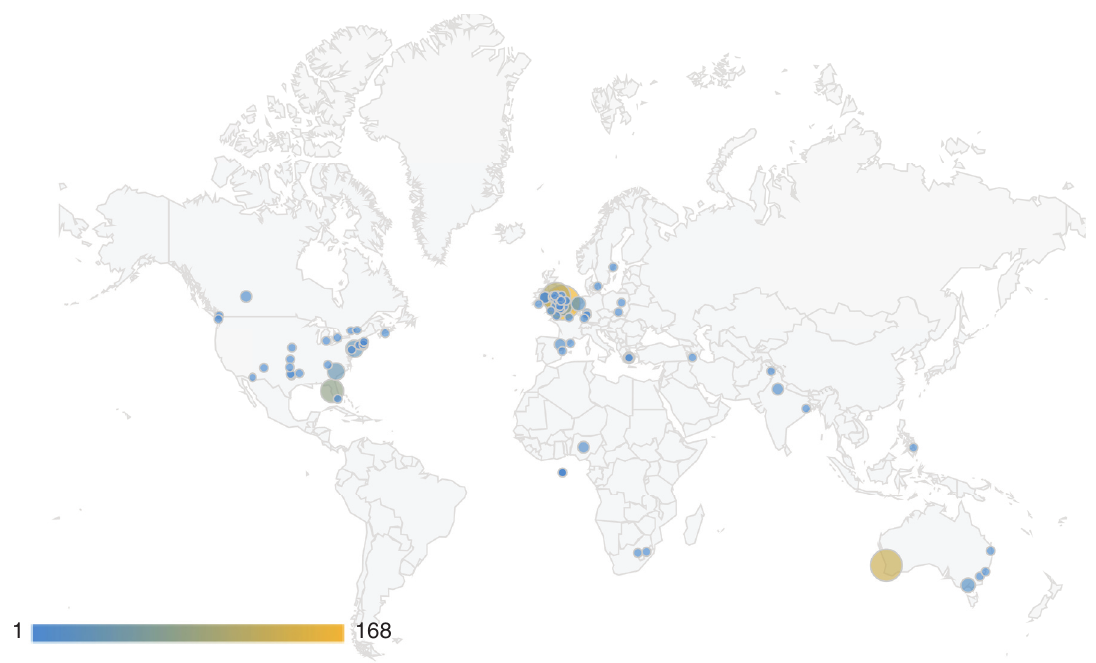
Figure 1. World map depicting the locations of participants in the ASTPC. Yellow points indicate multiple contributions, whilst blue data points indicate singular or near-singular contributions. Reproduced from data reports obtained from the website http://www.followthehashtag. com.